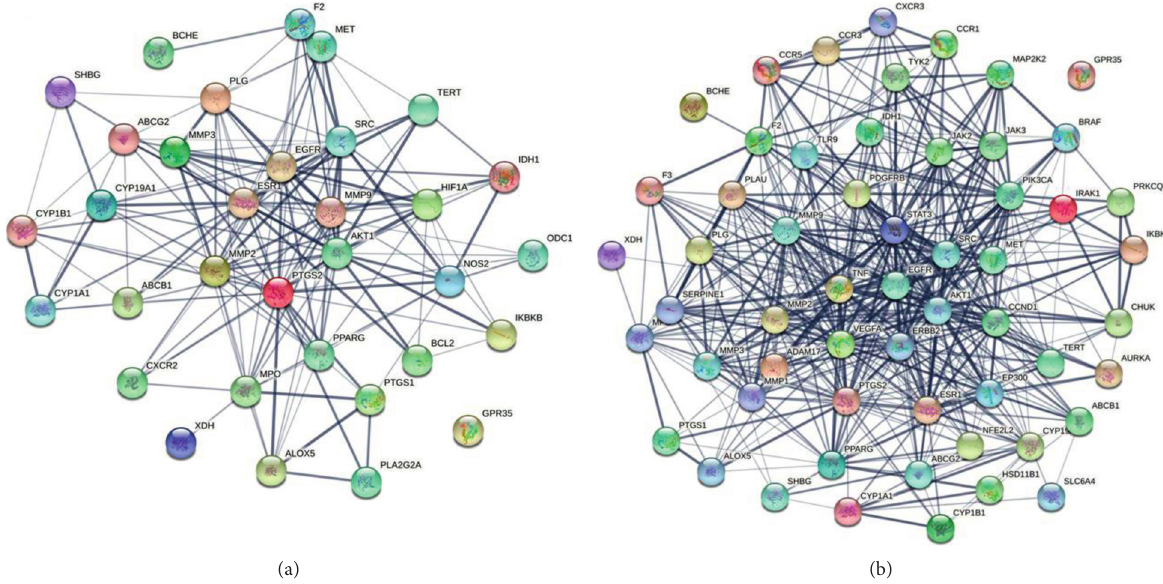
Figure 5: Topological analysis of the protein-protein interaction network. (a) Deoxyanthocyanidins before fermentation; (b) fermented deoxyanthocyanidins. Table 2: The lowest vina score for each docking.